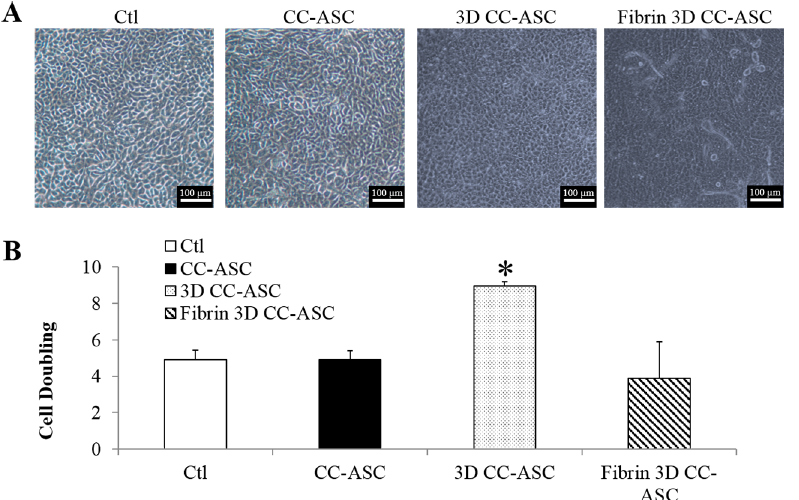
Fig 4. Cell clusters of limbal epithelial cells cultured on ASCs. (A) Cell morphology of culturedLSCs. The image for fibrin 3D CC-ASC was from the 33% culture which supportedepithelial expansion. (B) Cell doubling of limbalepithelialcells. * : p < 0.05in comparisonwith results of control, CC-ASC, and fibrin 3D CC-ASC cultures. Ctl: control. CC-ASC: cell clusters of LECs cultureddirectly on ASCs. 3D CC-ASC: cell clusters of LECs culturedon ASCs using the 3D method. Fibrin 3D CC-ASC: cell clusters of LECs cultured on ASCs using the fibrin 3D method. Scale bar = 100 μ m.